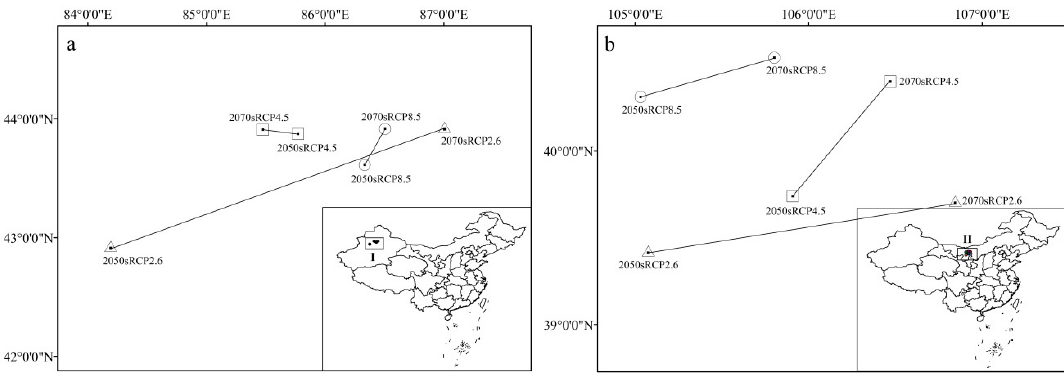
Figure 7. The core potential geographical distribution of C. deserticola under di ff erent RCPs in 2050s ( a ), and 2070s ( b ).